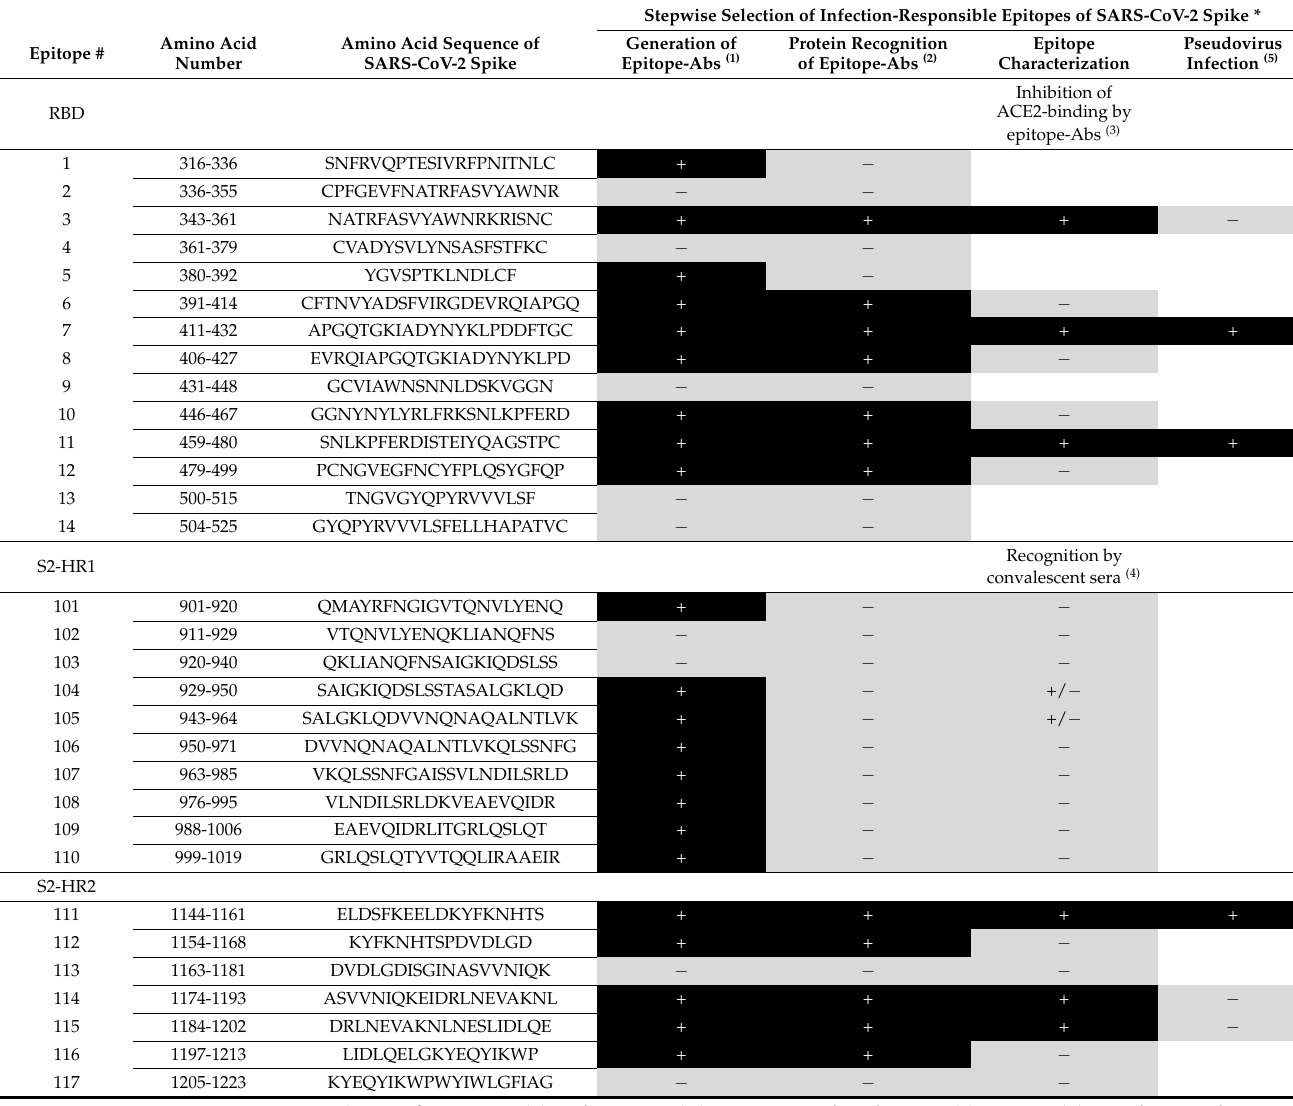
Table 2. Summary of process to identify Ab-epitopes protective SARS-CoV-2 pseudo-virus